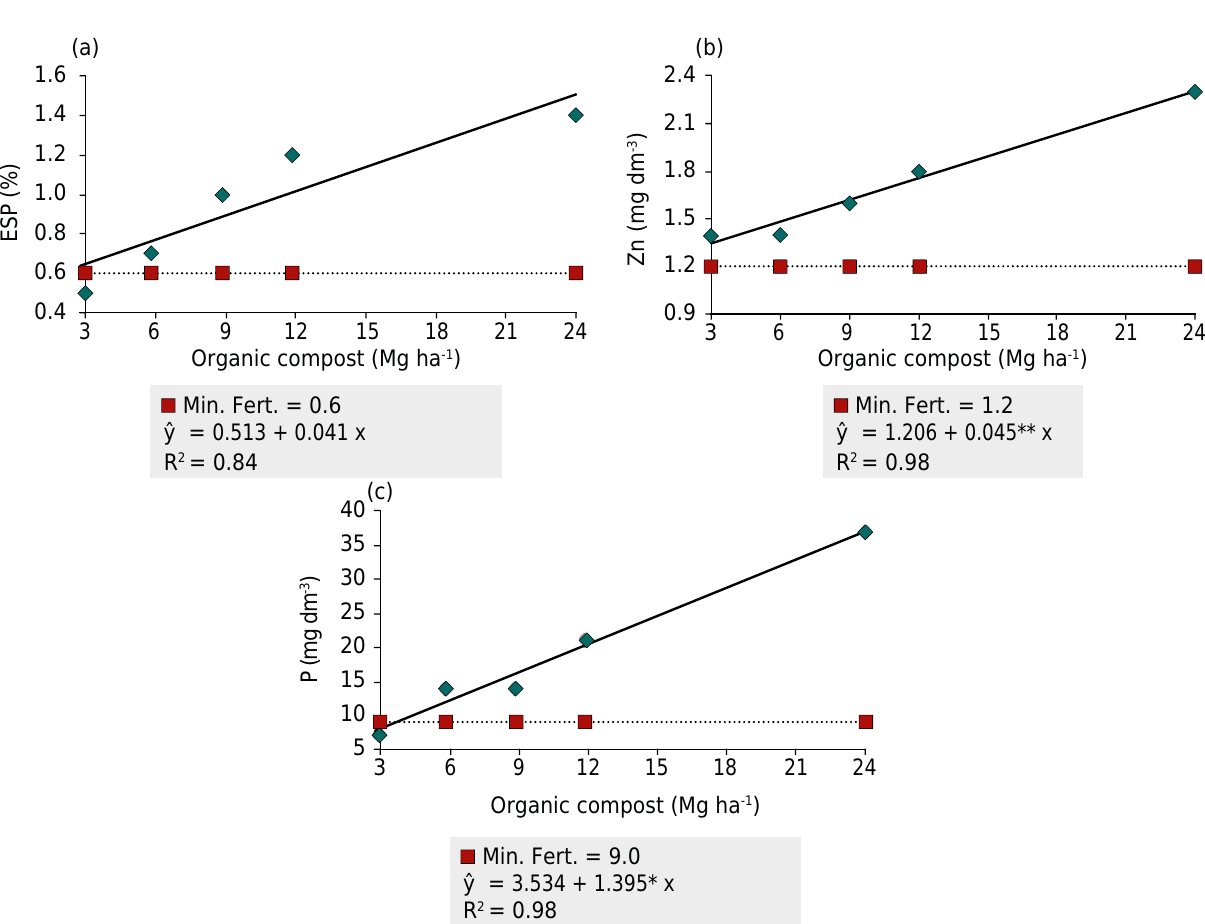
Figure 3. Percentage of exchangeable sodium - ESP (a) and zinc concentration (b) in the surface layer (0.00-0.20 m); concentration of phosphorus (c) in the subsurface layer (0.20-0.40 m) for the 2014 crop, as a function of application rates organic compost. * and ** : significant at 5 and 1 % probability, respectively. Min. Fert.: Mineral